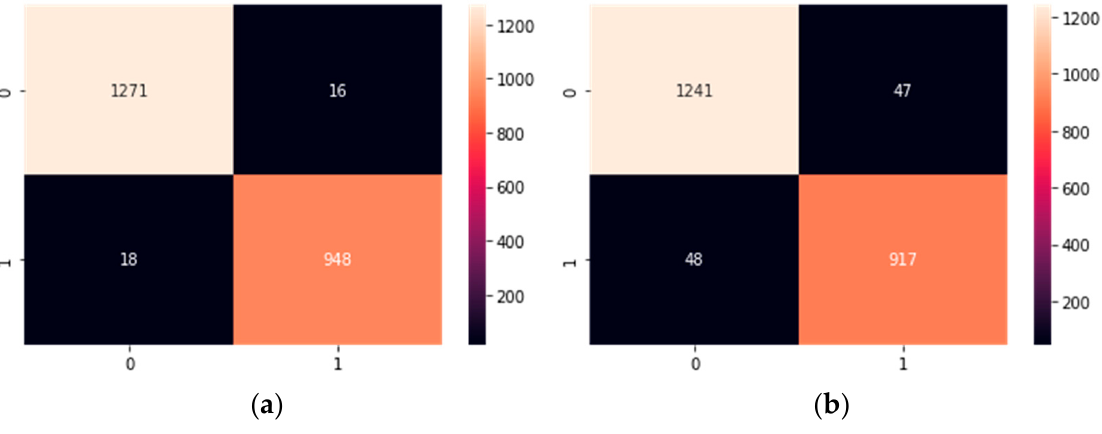
Figure 5. The confusion matrices of BERT EN ( a ) and AraBERT ( b ).